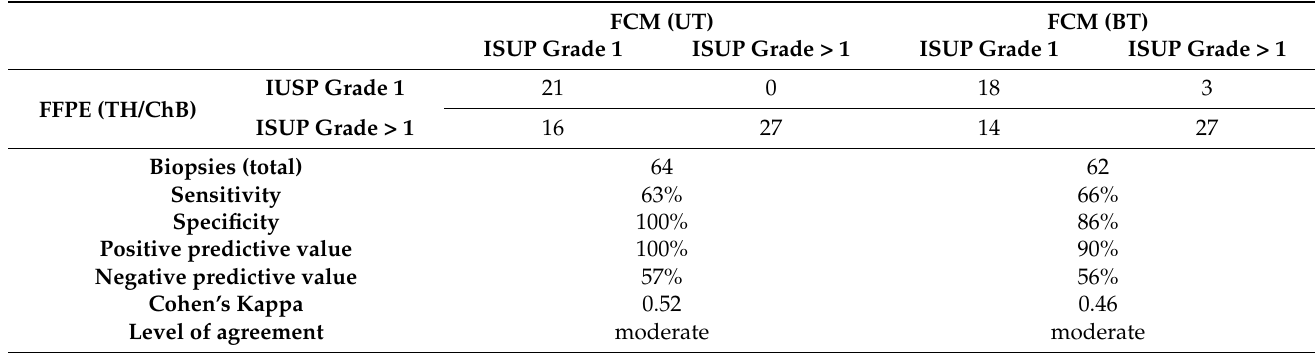
Table 4. Comparison of ISUP grades in FCM scans and conventional histology.